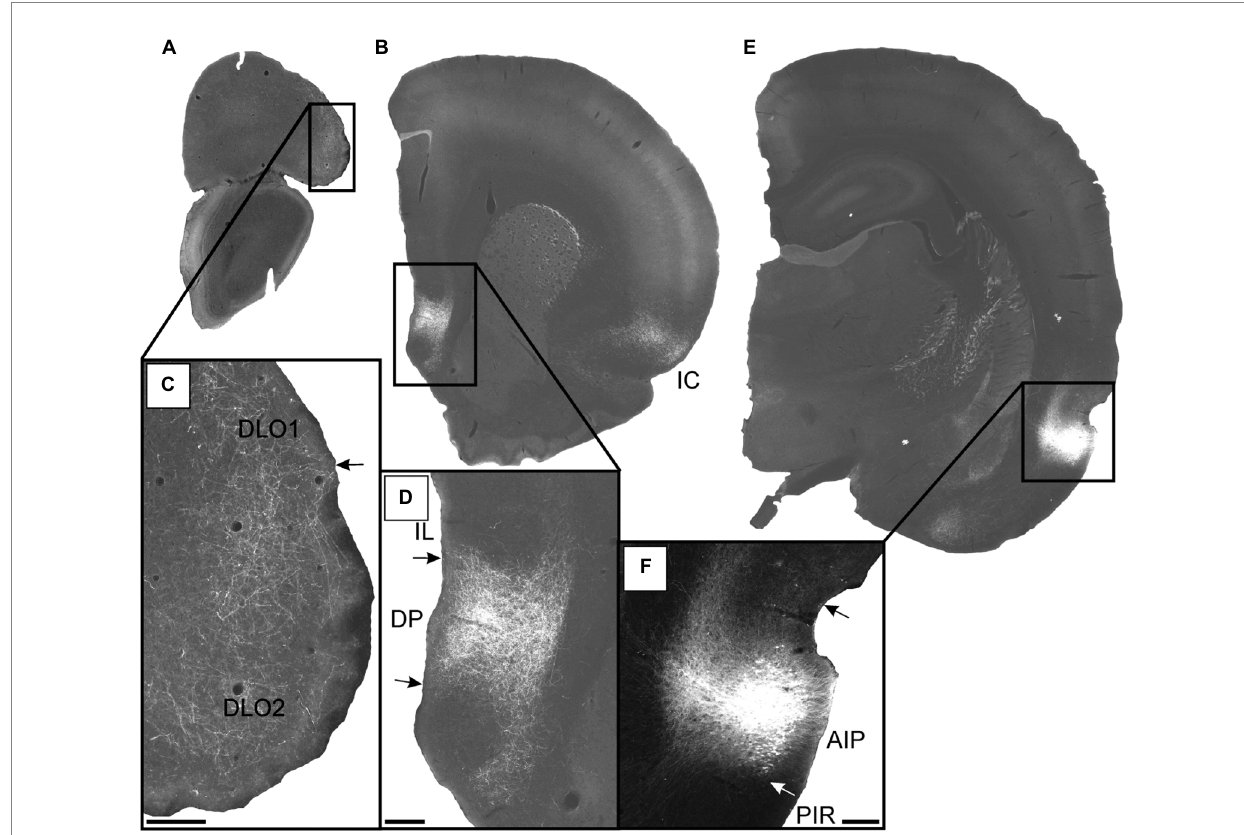
FIGURE 10 Images visualizing the fiber projections from the agranular field of the parietal insular domain (case 12949B). (A,B) Low-resolution images of frontal sections with boxes indicating the areas of higher-resolution images shown in C and D . (C) Dense fiber labeling is present in the dorsolateral orbital fields DLO1 and DLO2. (D) A densely labeled fiber plexus is present in the dorsal peduncular cortex. (E) Low-resolution image of section with box indicating the area of higher-resolution image shown in F . (F) The center of the BDA injection in the agranular parietal insular cortex. A smaller portion of the tracer deposit extends into the dysgranular parietal insular cortex. AIP, parietal agranular insular field; DLO1, dorsolateral orbital field 1; DLO2, dorsolateral orbital field 2; DP, dorsal peduncular cortex; IC, insular cortex; IL, infralimbic cortex; PIR, piriform cortex. Scale bars equal 200 μ